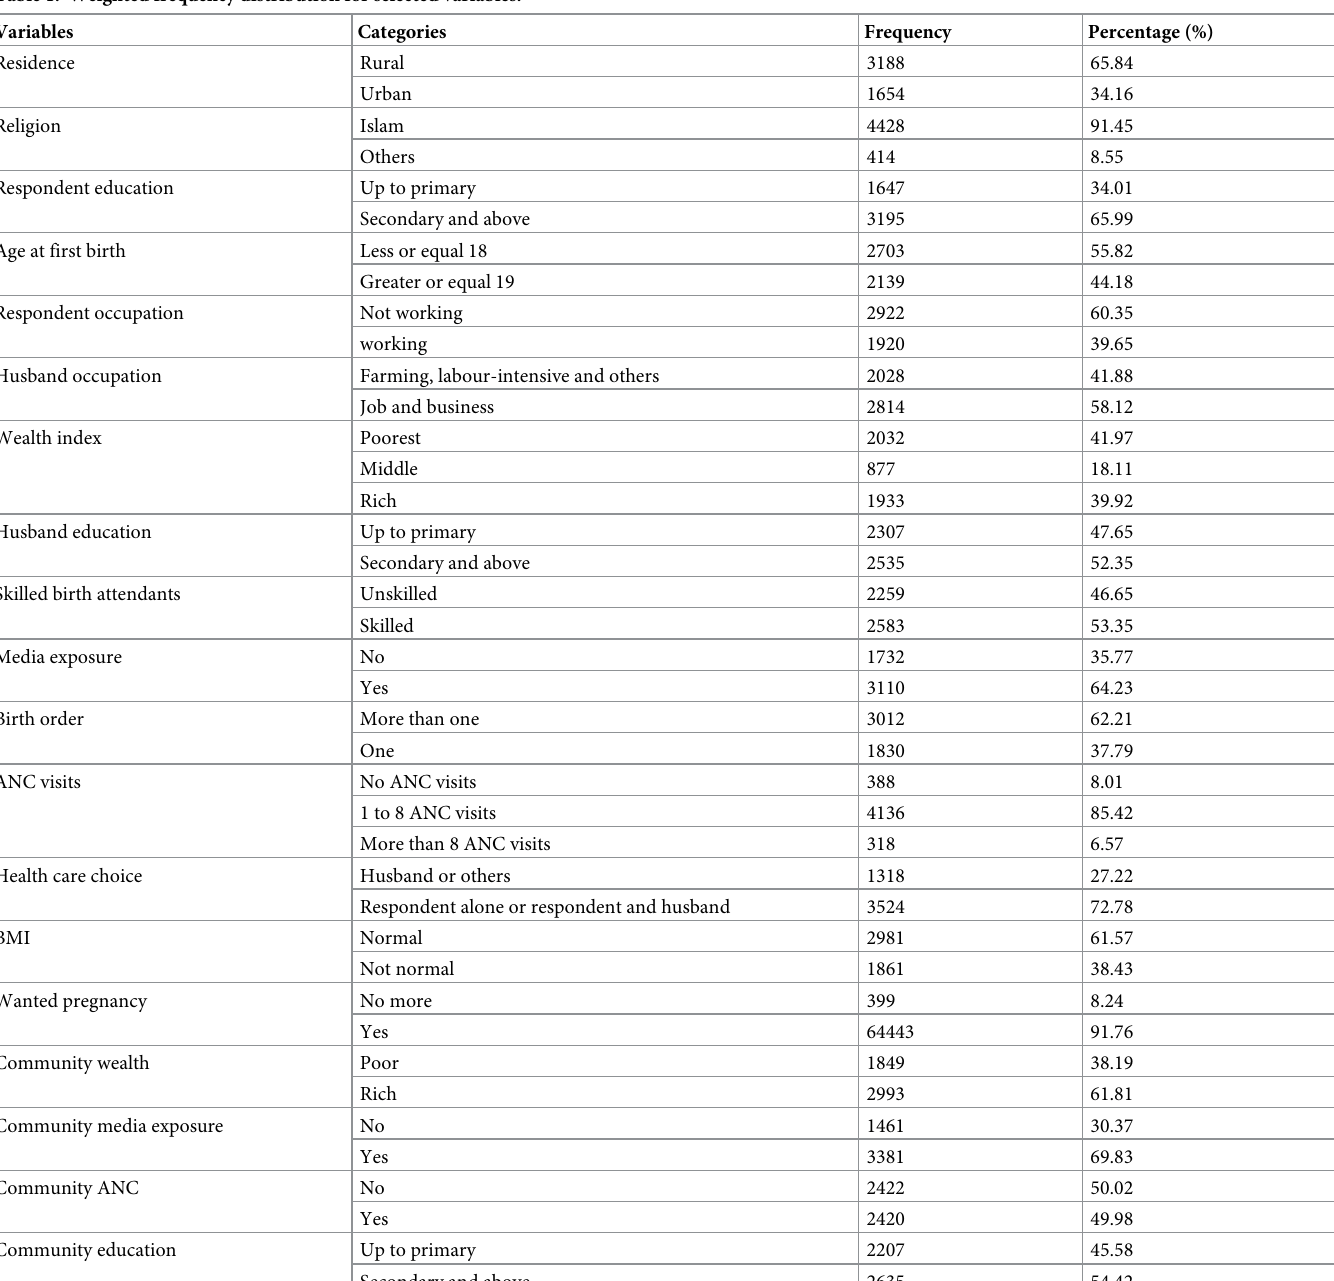
Table 1. Weighted frequency distribution for selected